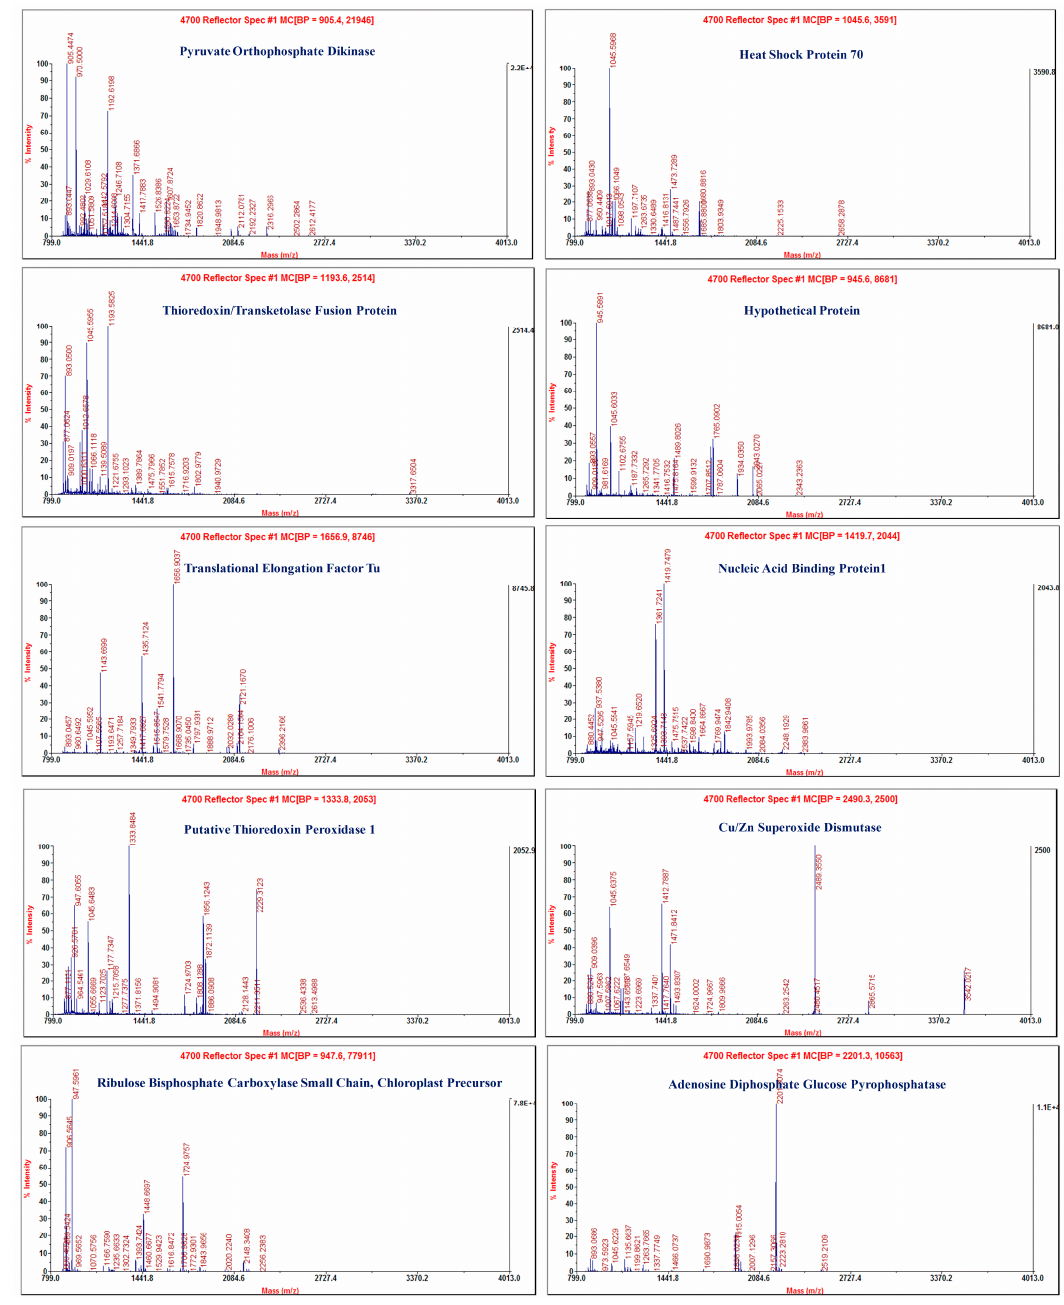
Figure 2. Peptide mass fingerprinting of differentially expressed proteins associated with sugarcane varieties F134 and NCo310 after Sporisorium scitamineum inoculation.